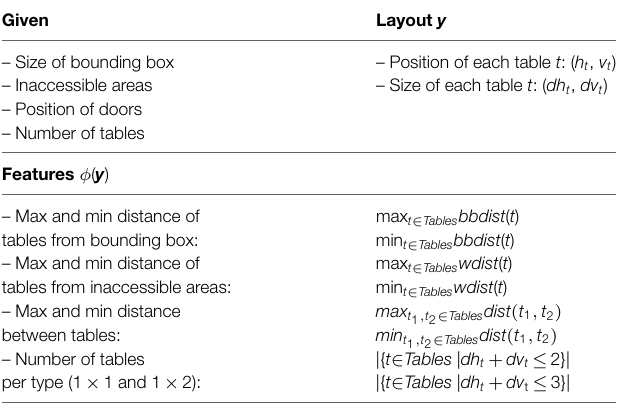
Tablesisthesetoftables,bbdist(t)isthedistanceoftabletfromtheboundingbox,wdist(t) isthedistanceoftabletfromtheinaccessibleareas(walls),dist(t 1 ,t 2 )isdistancebetween tables t 1 and t 2 . All distances considered are Manhattan distances (to keep linearity of constraints).